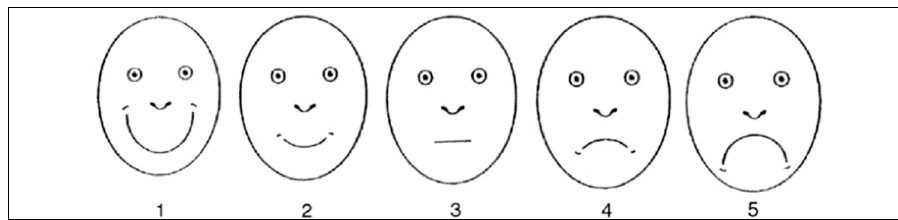
Figure 1. The Wong–Baker face scale.